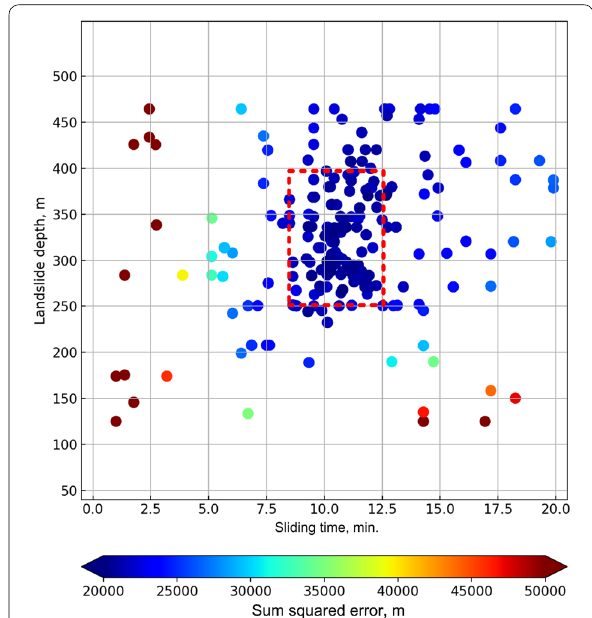
Fig. 7 Global optimization results, where the colored points give the value of the objective function for each simulation run. The number of simulations was set to 1500 with 30 populations over 50 iterations, and the red dashed box in the figure represents the approximated area of the last